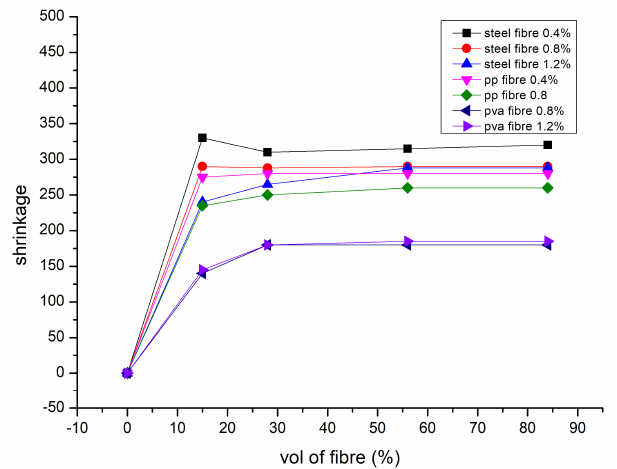
Figure 13. Shrinkage in micro strains [10].